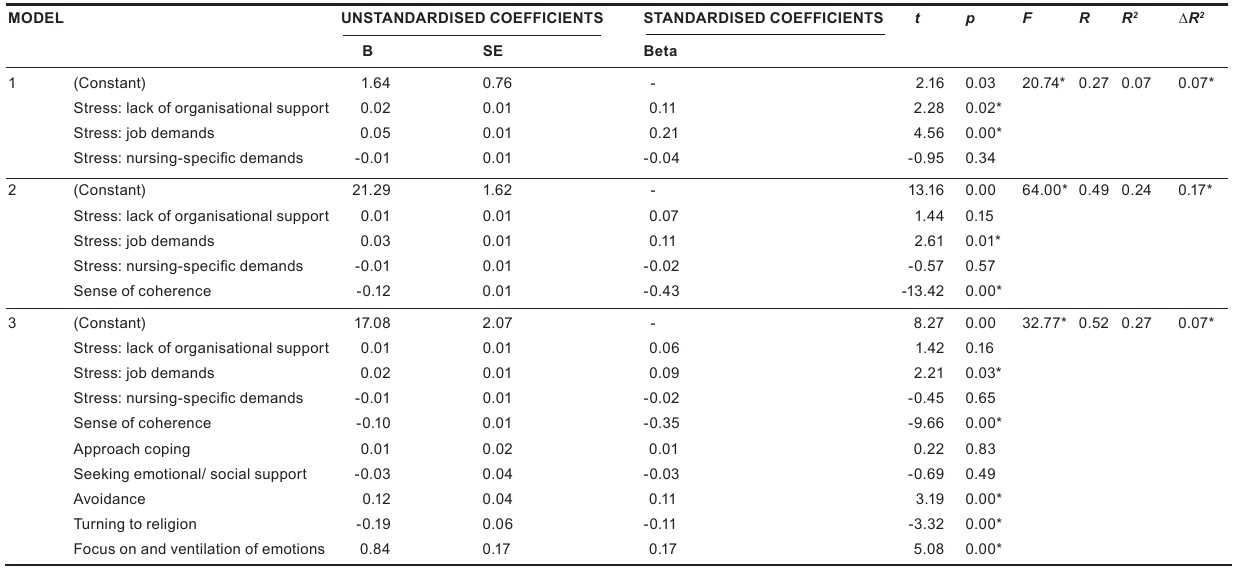
TABLE 4 Multiple regression analysis with Depersonalisation as dependent variable and Occupational Stressors, Coping Strategies and Sense of Coherence as independent variables